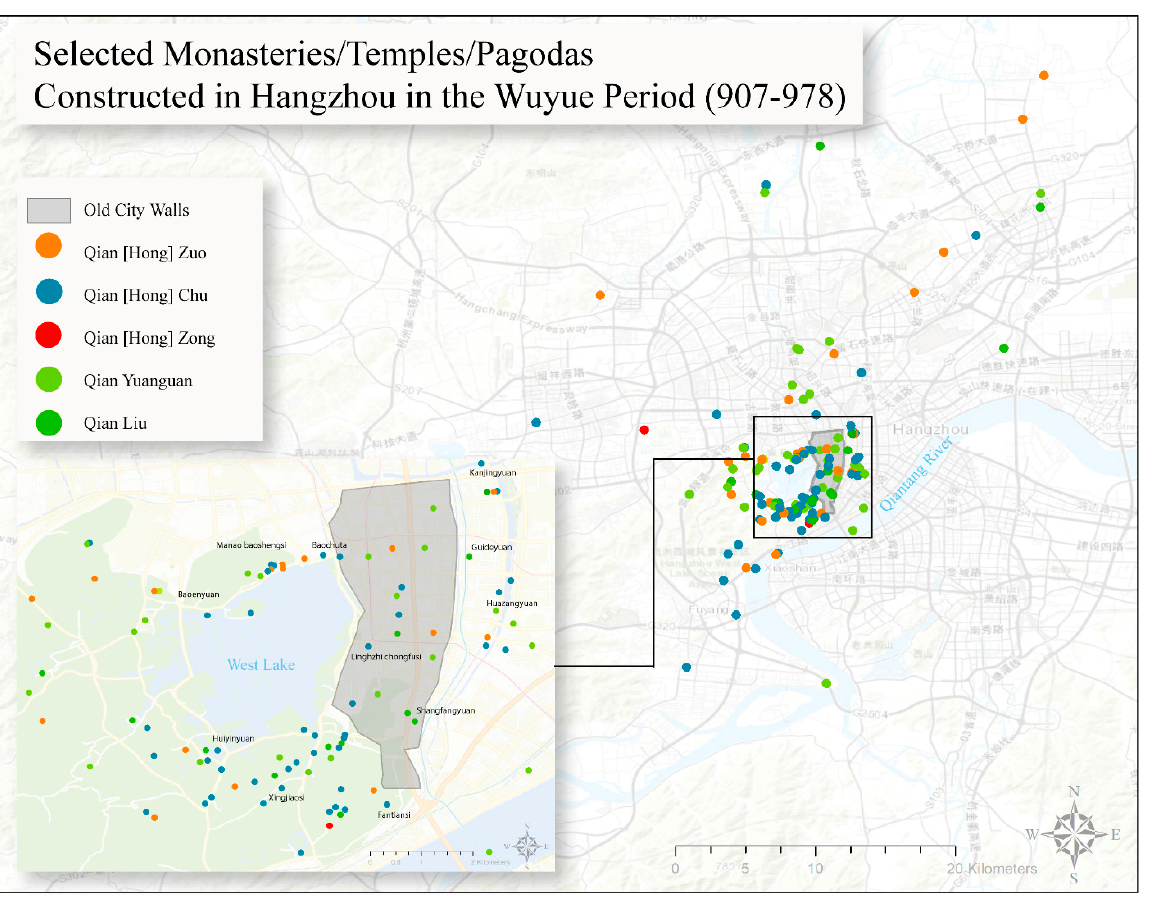
Figure 1. Selected record of monasteries/temples/pagodas constructed in Hangzhou in the Wuyue period. Source: Hangzhou Prefecture Gazetteer (1784) and University of Arizona BGIS Southern Song Dynasty Hangzhou dataset. Map by Philip Stoker.